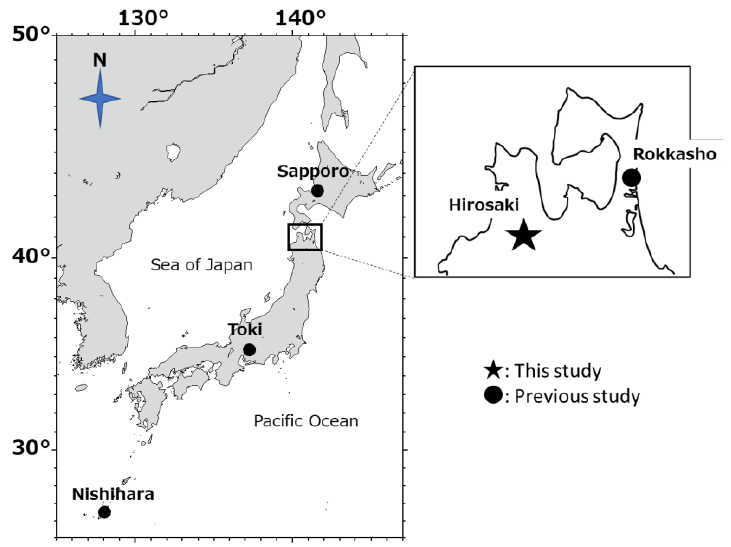
Figure 1. Location of the present sampling point (Hirosaki City) and of the previously reported sampling points (the cities of Sapporo, Rokkasho, Toki and Nishihara).